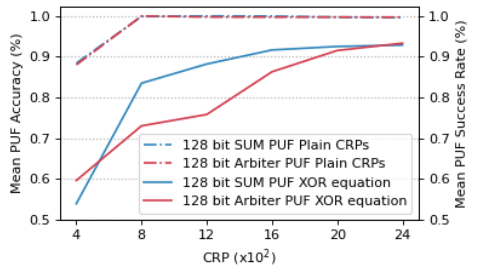
Figure 10: Comparison between mean PUF accuracy for learning a 128 bit APUF and a 128-SUM PUF through CRP s and PUF success rate when learning the same PUF s through HD